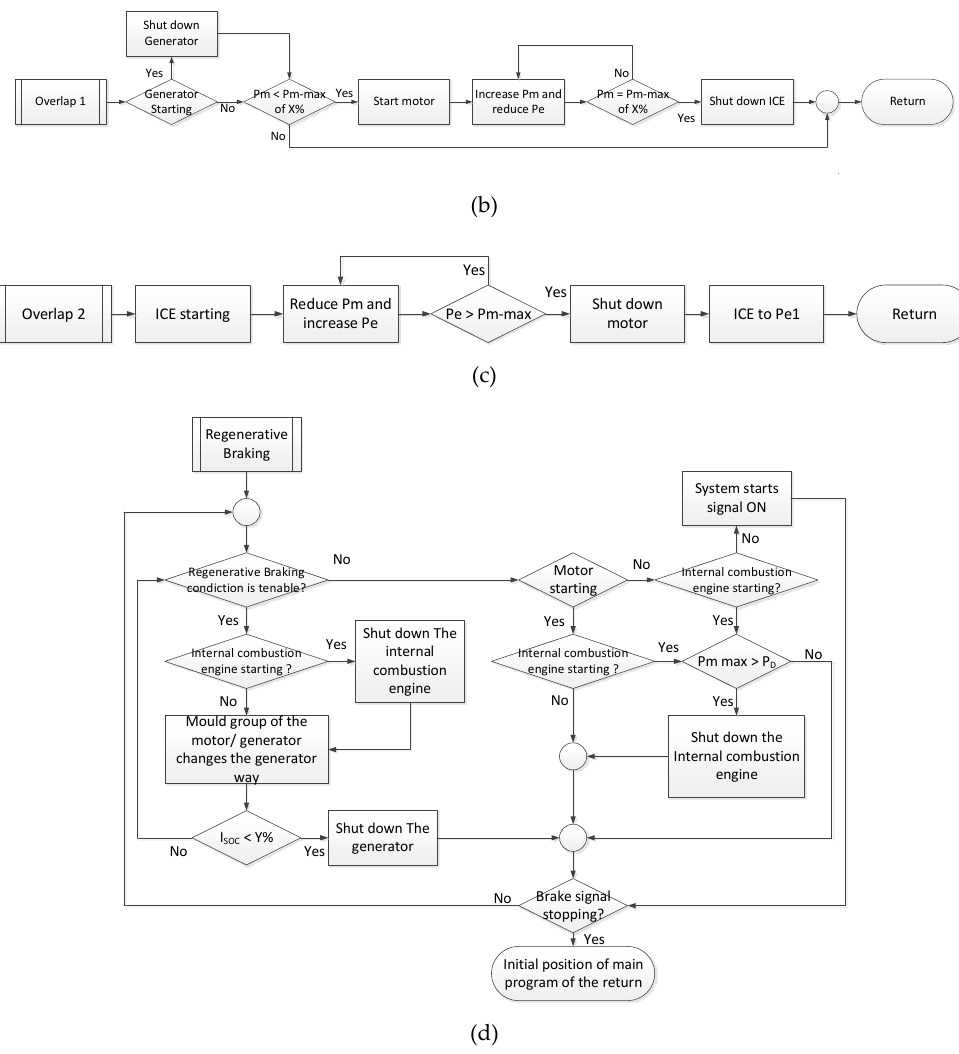
Figure 2. ( a ) Power system energy management strategy, ( b ) overlap 1, ( c ) overlap 2, ( d ) brake energy recharge management strategy. recharge management